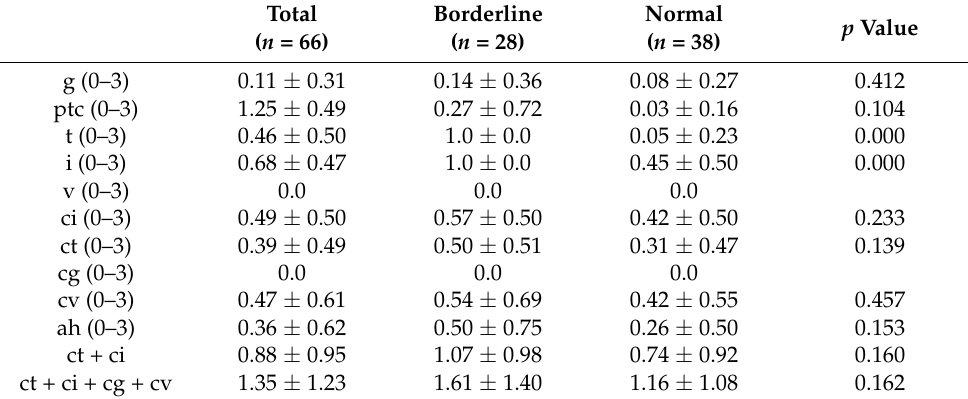
Table 2. Histological biopsy score in the third